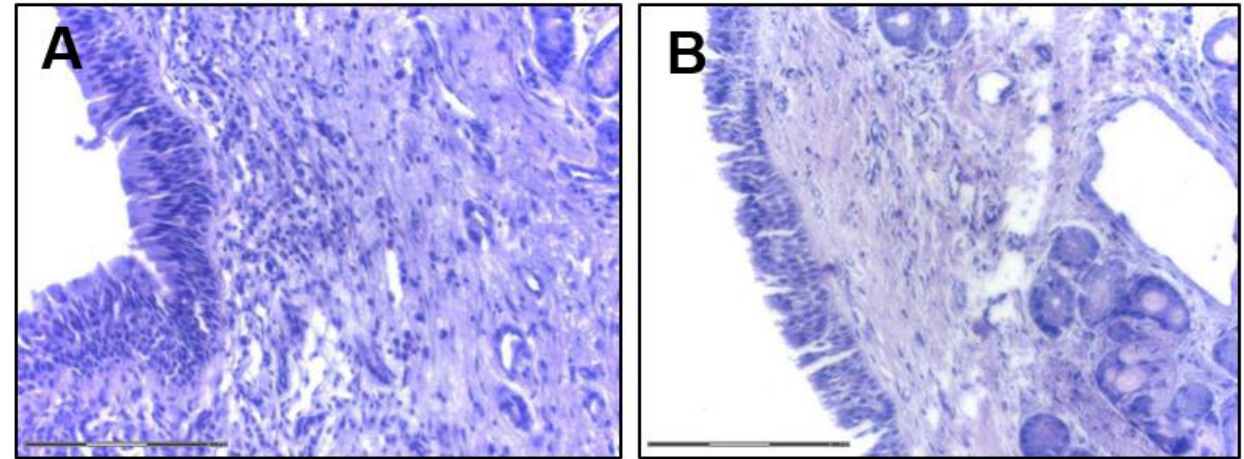
Figure 4. Sinusal airway epithelium (H and E staining, bar indicates 150 µ m; courtesy of K. Piszcza- towska). ( A ) CRSwNP; ( B ) CRSsNP.